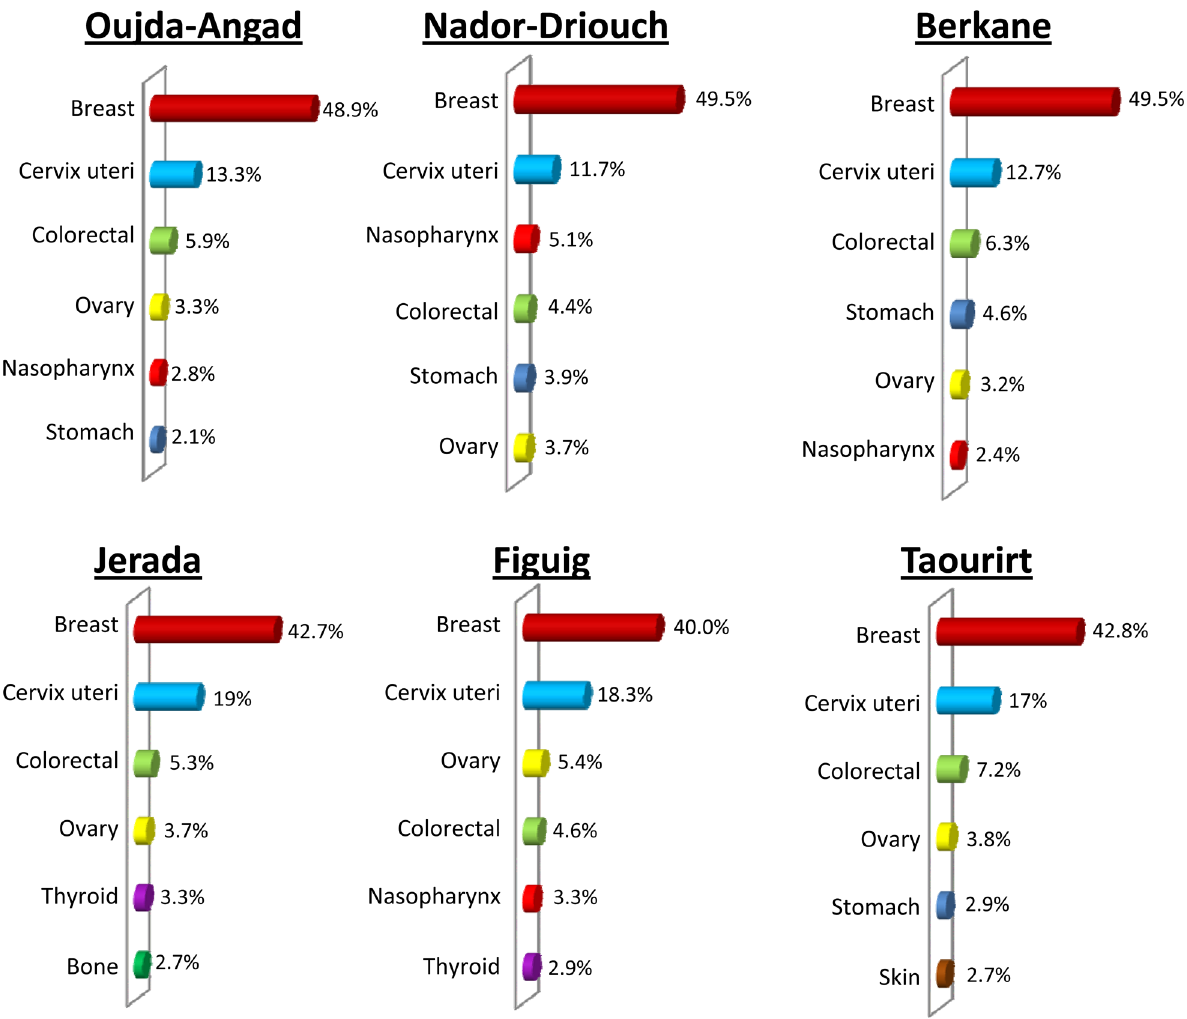
Fig 3. Distribution pattern of major cancer sites in females by area of Eastern Morocco, October 2005 – December